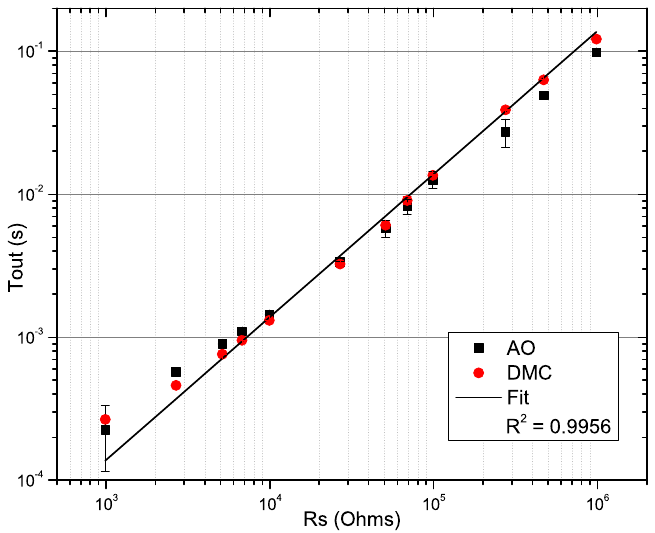
Figure 13. Experimental results from two discrete component prototypes: the first implemented with transistors from the AO4614 (AO, square) family and the second from the DMC4050 family (DMC, circle). Correlation coefficient equal to 0.9956.